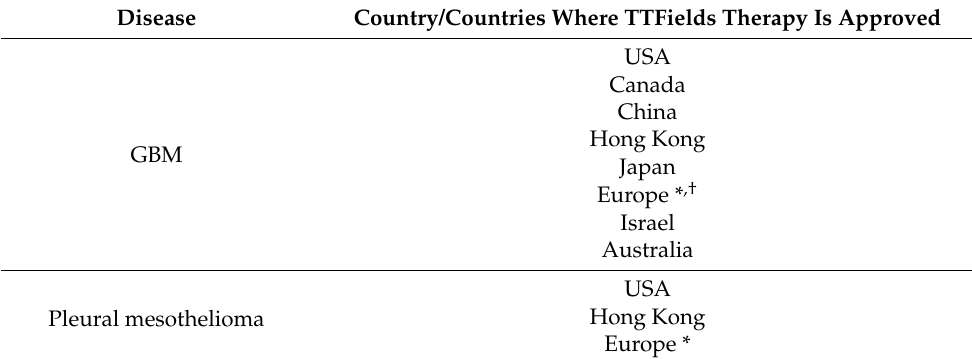
Table 1. A summary of the global approval status of TTFields therapy.